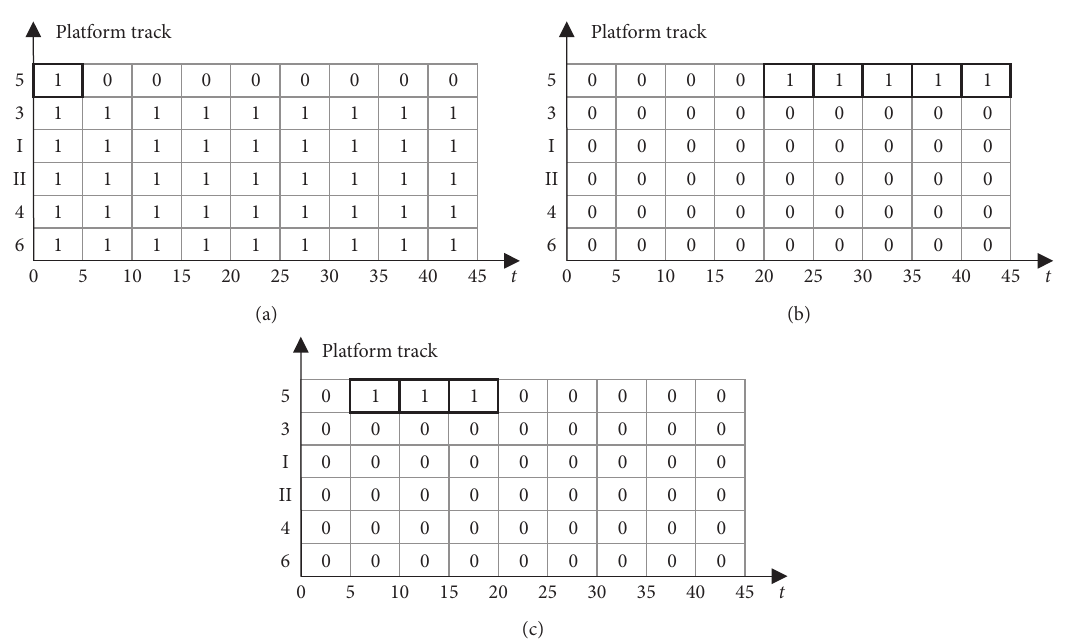
Figure 3: An illustrative example showing the values of platform track state variables u (b) values of the variable v l,i,t ; (c) values of the variable x l,i,t , and x l,i,t � 1 − ( u l,i , t + v l,i,t